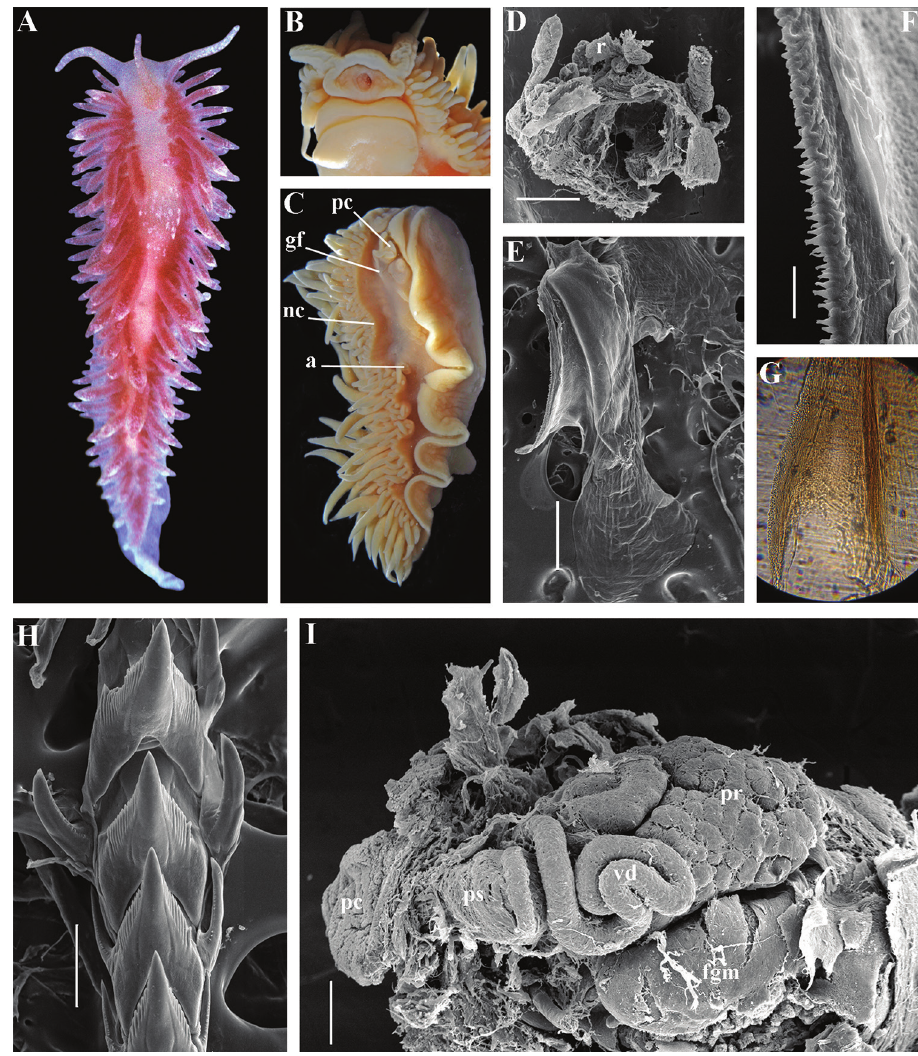
Figure 4. Chlamylla borealis orientalis (Volodchenko, 1941), comb. n. ZMMU Op-478. The Sea of Japan, Vostok Bay, 15 mm in length: A living animal, dorsal view B fixed animal, ventral view of anterior part C fixed animal, lateral view D dissected anterior part (pharynx removed) and rhinophores, SEM E jaw, SEM F details of masticatory process of jaw, SEM G details of masticatory process of jaw, light microscopy H radular teeth, posterior part, SEM I reproductive system, SEM. Abbreviations: a anus gf genital fold fgm female gland mass nc continuous notal edge pc penial collar (external) pr prostate ps penial sheath r rhinophores vd vas deferens (muscular part). Scale bars: D = 1 mm; E, I = 300 μm; F = 30 μm; H = 100 μm. Photos and SEM images by A.V.